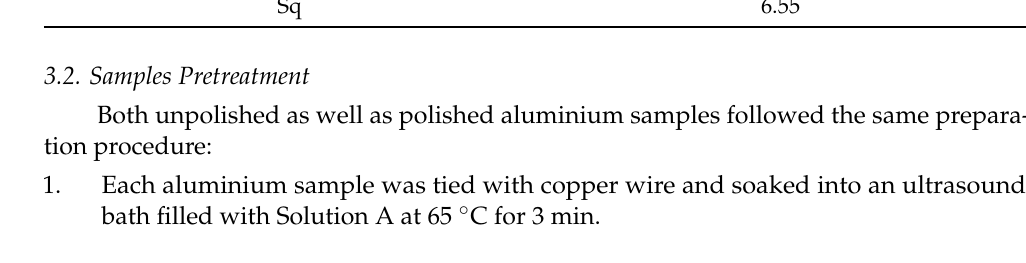
Table 3. Polished Al6082 aluminium surface roughness, values were obtained from AFM analysis. Roughness